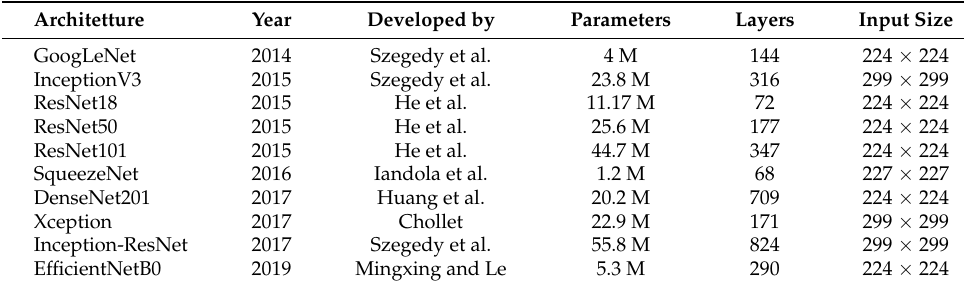
Table 3. Overview of common CNNs